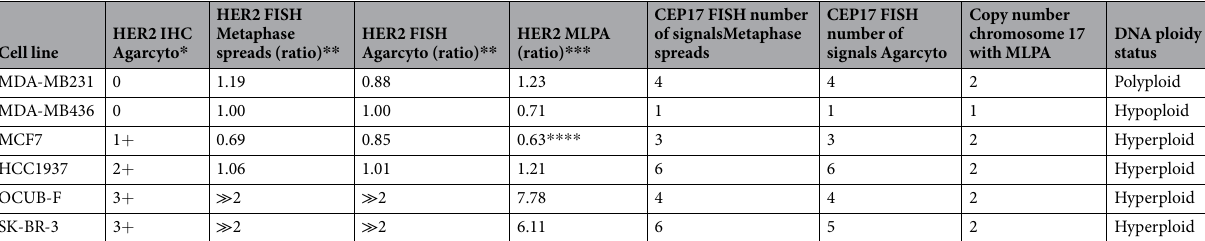
Table 1. Results of the breast cancer cell lines. * Scoring of 0, 1 + , 2 + or 3 + , ** Ratio of spots for the HER2 gene and CEP17; mean value of 2 independent estimations; *** Ratio as mean value of both MLPA kits used; **** Partial loss of the HER2 gene.